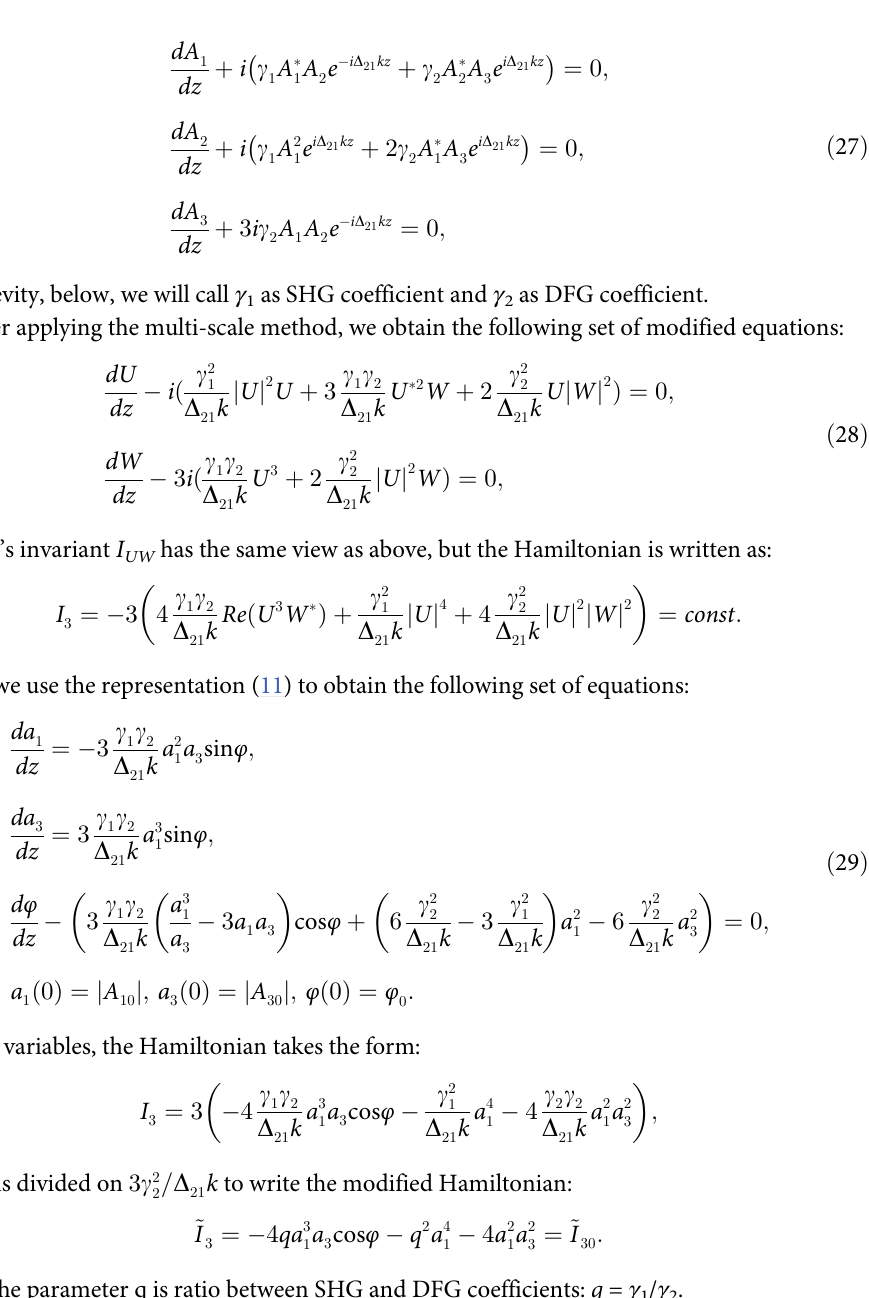
ffiffiffiffiffiffiffiffiffiffi p Þ f ð p 1